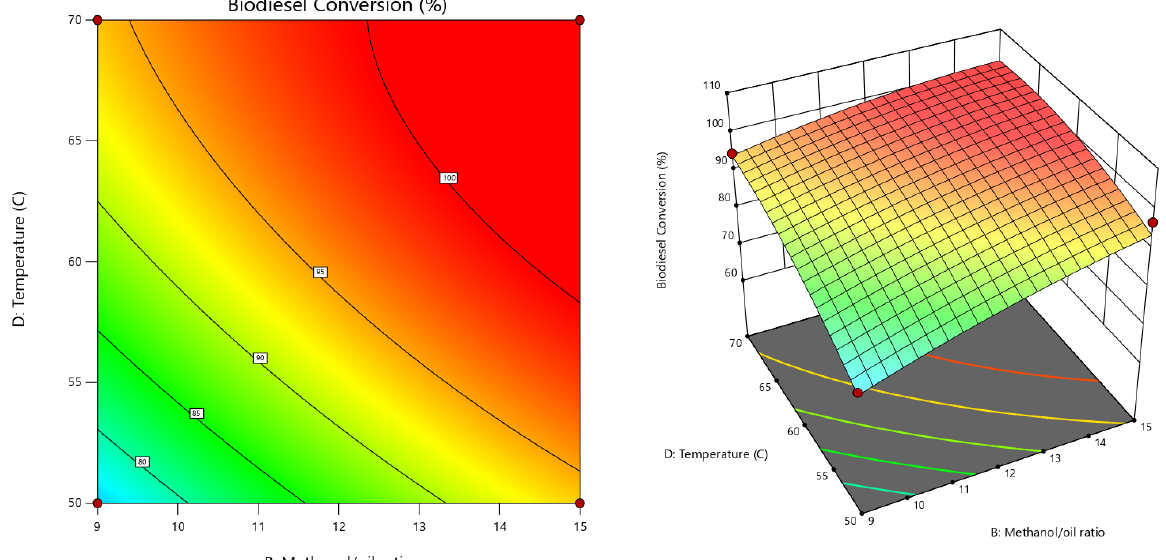
Figure 19. Relationship between the reaction temperature, methanol to oil ratio, and the yield of biodiesel (Contour and 3D plot).